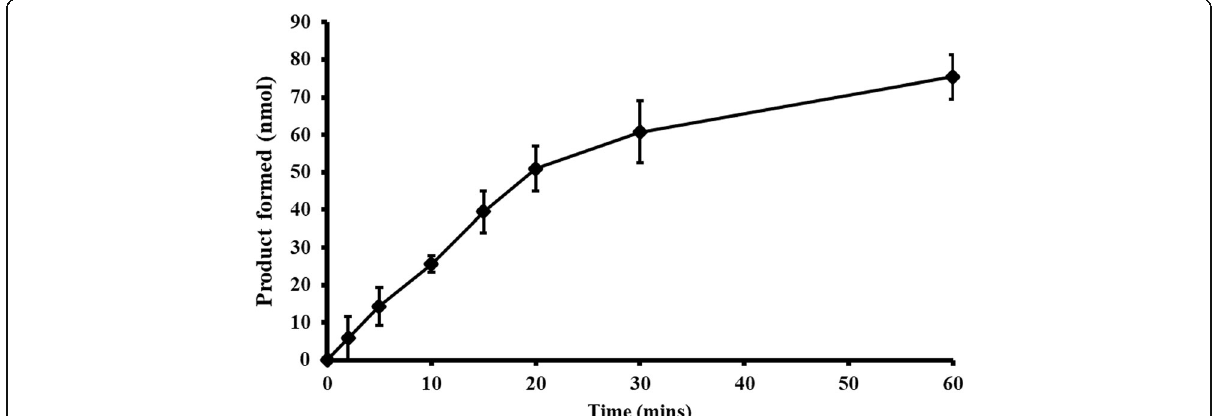
Fig. 2 Time-dependent lysis of fatty acids from the membrane of fluorescently labeled E . coli incubated with plasma derived from Crotalus viridis . The results represent the means ± sd of four independent